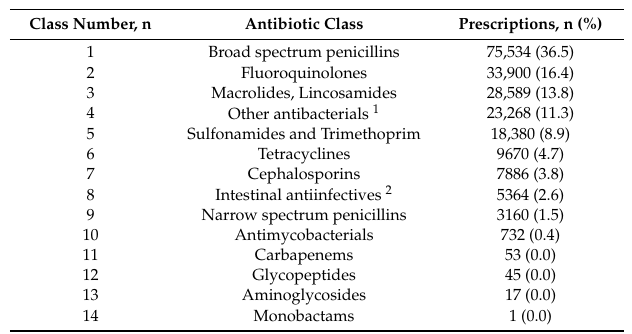
Table 1. Distribution of 206,599 antibiotic prescriptions in 112,378 patients in Swiss primary care for the period 2008–2020.